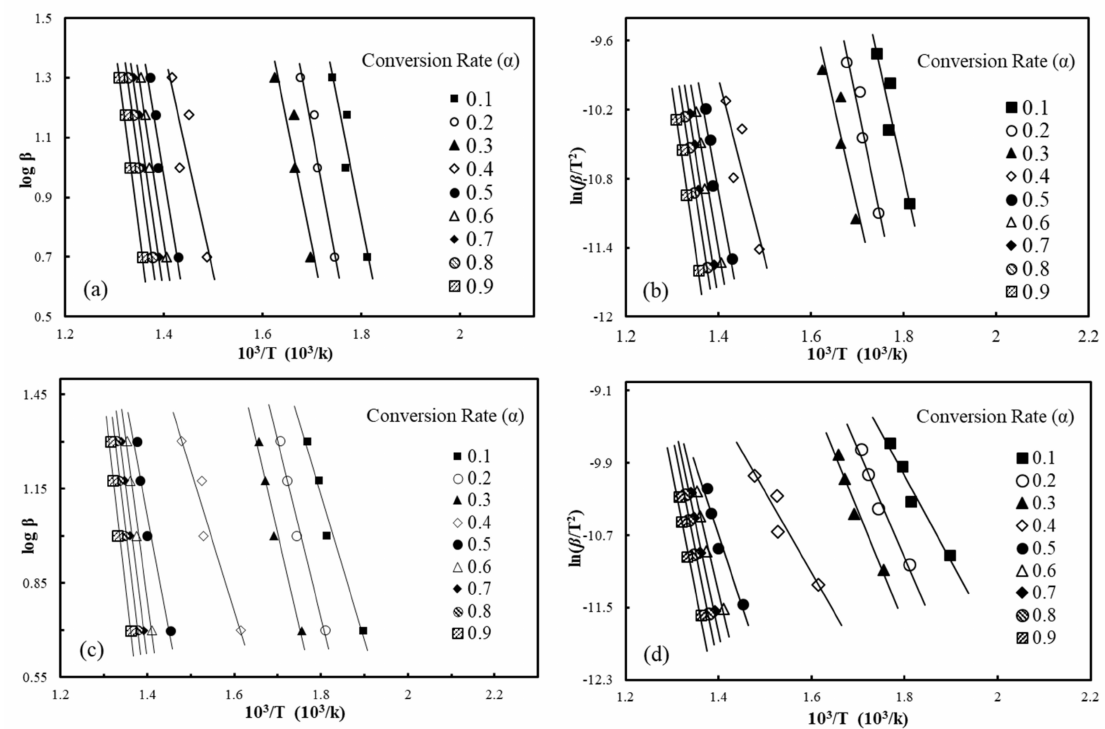
Figure 4. Iso-conversion plots of the iso-conversion plots of the Flynn-Wall-Ozawa (F-W-O) method for waste HDPE ( a ); A2 ( c ), the modified Coats-Redfern (C-R) method for waste HDPE ( b ); A2 ( d